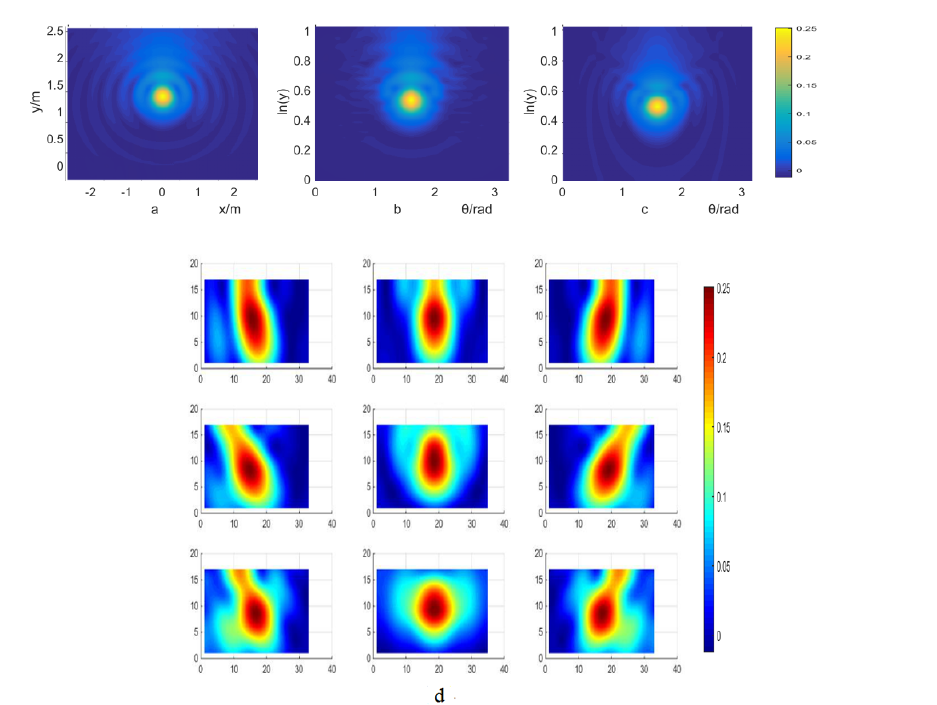
Figure 6. The 3 GHz PSFs of different methods: ( a ) the PSF of direct deconvolution algorithm; ( b ) the polar transformation’s PSF; ( c ) the PSF of our method; and ( d ) the PSF of the segmentation